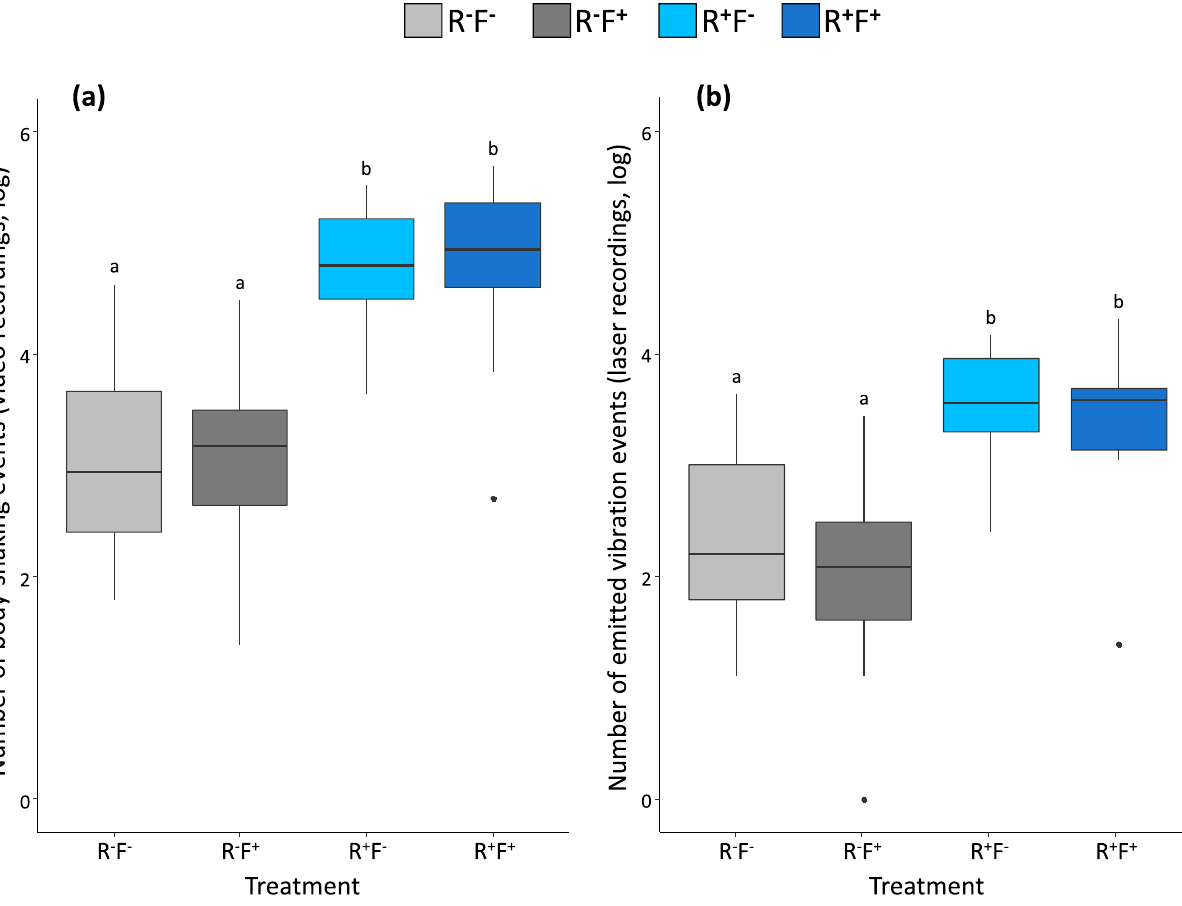
Figure 2. Total number of body-shaking events during video recordings ( a ) and total number of the emitted vibrations measured by laser recordings ( b ) in the four different treatments: absence of reproductives (R − ), presence of reproductives (R + ), absence of flashlight (F − ), presence of flashlight (F + ). Different letters refer to p <